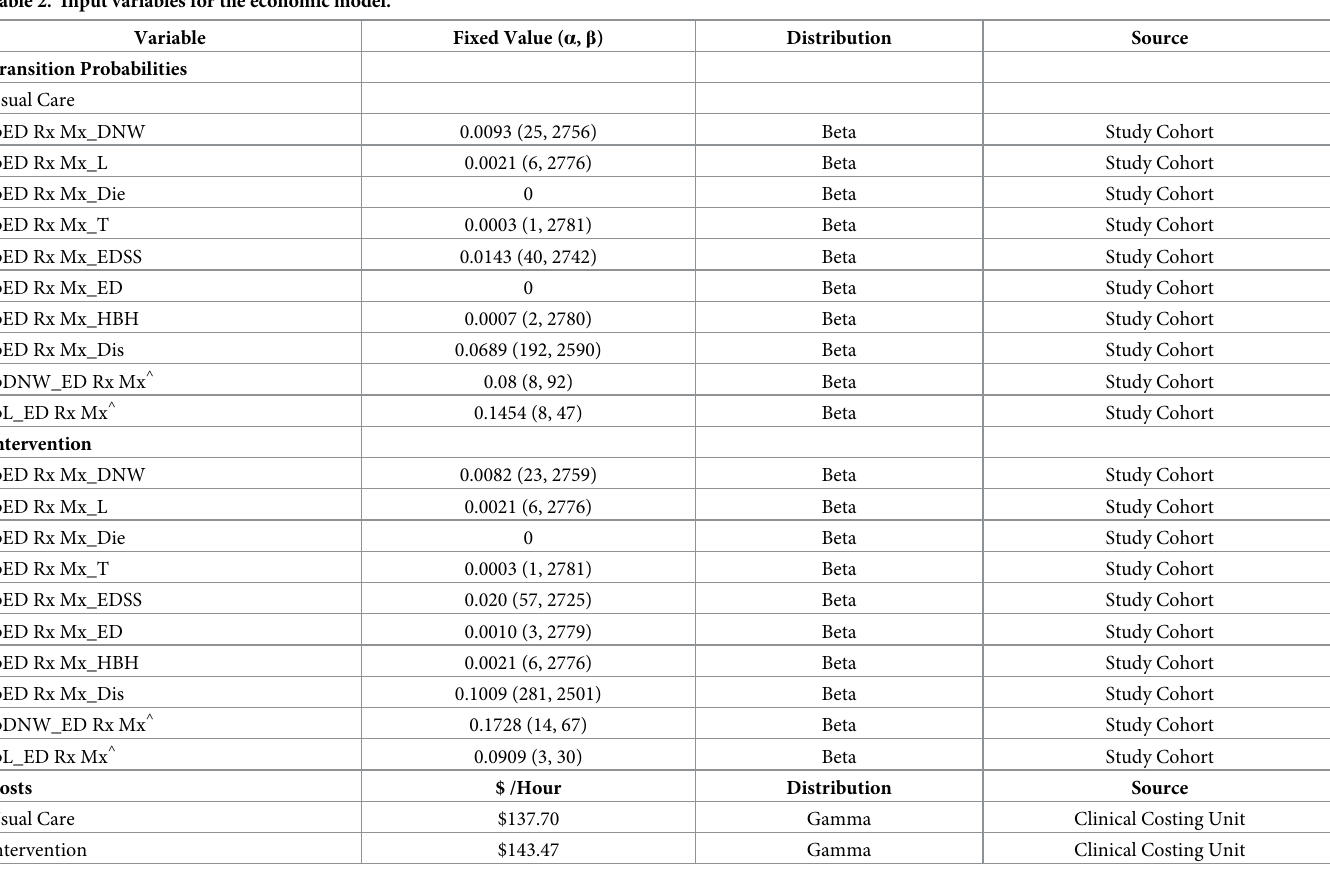
Table 2. Input variables for the economic